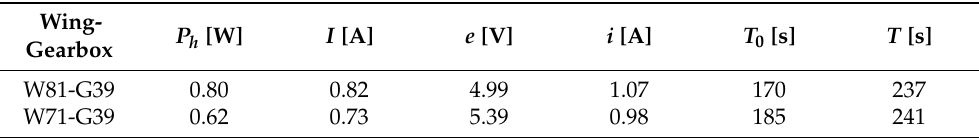
Table 6. Two batteries B2 in series and Motor M2. Lift: L = 22.8 gr. I is the motor current and i is the battery discharge current. T is the estimated flight time.